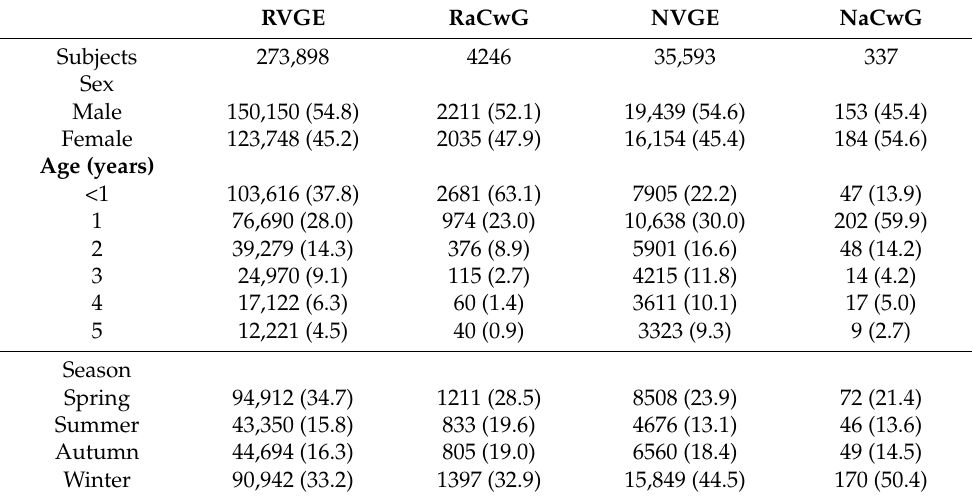
Table 1. Characteristics of patients with rotavirus gastroenteritis (RVGE), rotavirus-associated benign convulsion with mild gastroenteritis (RaCwG), norovirus gastroenteritis (NVGE) and norovirus- associated CwG